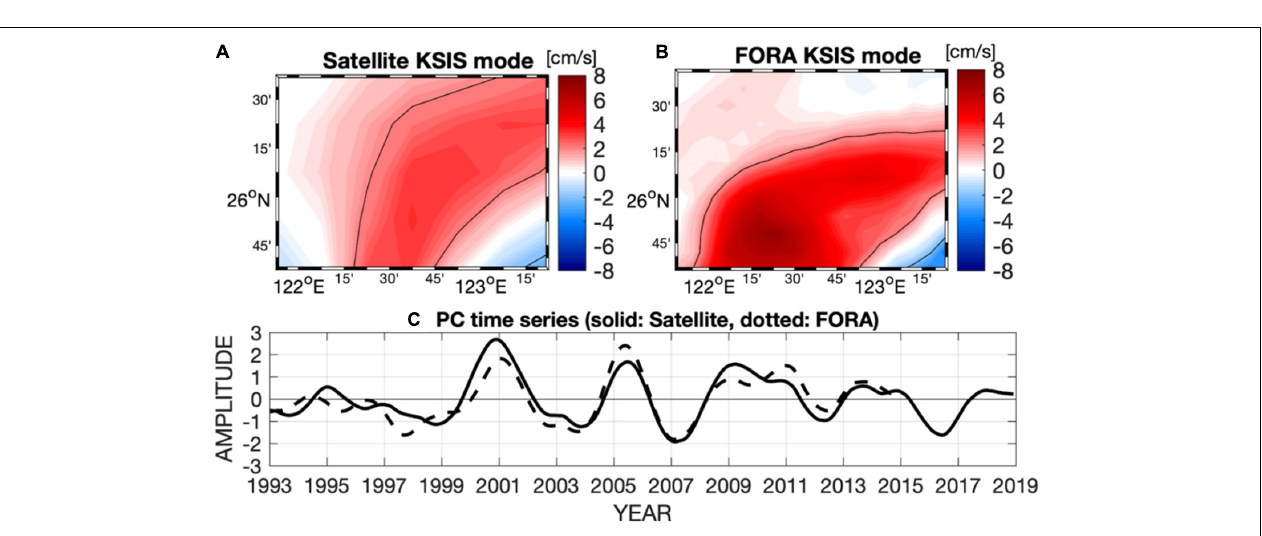
FIGURE 3 | Kuroshio shelf intrusion strength modes (the second CSEOF modes of the surface current speed over the KSI domain) depicted from (A) satellite altimetry during 1993–2018 and (B) FORA during 1993–2014 with the corresponding PC time series in panel (C) . Black contours in panels (A,B) denote 2 cm/s. The correlation coefficients between the solid and dotted line in panel (C) is 0.87 during the period